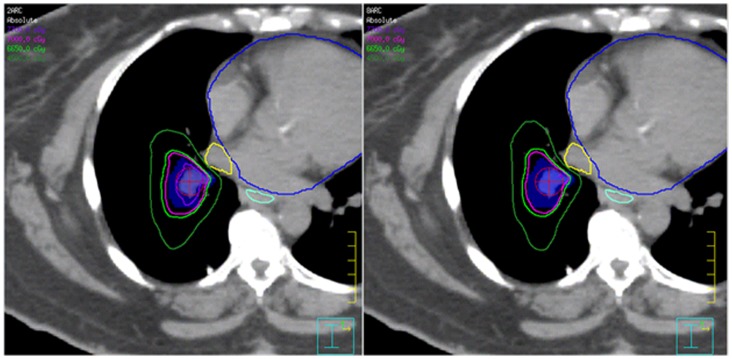
Illustration of a comparison of the 2 and 8 Arc plans demonstrating that the shape of the isodose covering the PTV is largely dependent on the immediately adjacent critical structures (yellow and blue) that need to be spared in one patient.As a result, slightly increased volume of the normal lung tissue is included in the high dose volume lateral to the PTV (blue shade) away from the central structures. Also shown here is that when comparing to the 2 Arc plan, the high dose region included by the 77 Gy isodose in the 8 Arc plan is greatly diminished, demonstrating increased homogeneity.